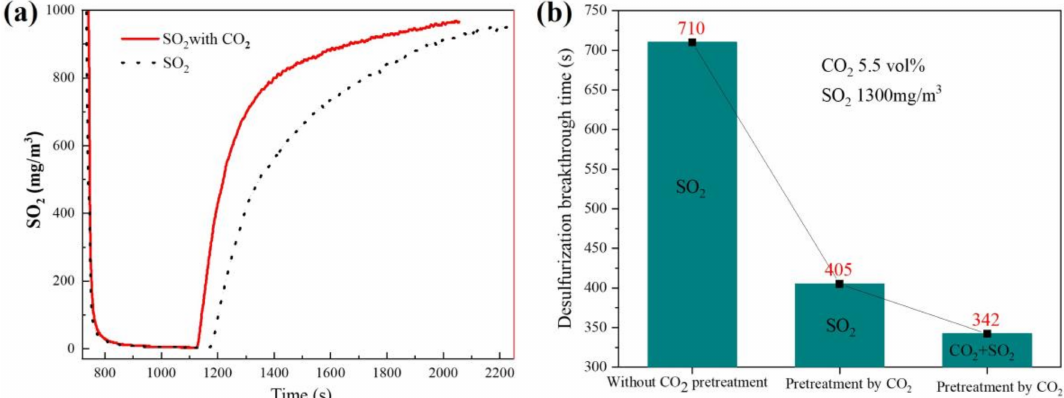
Figure 12. Effect of CaCO 3 on ( a ) desulfurization and ( b ) desulfurization penetration time under different conditions.